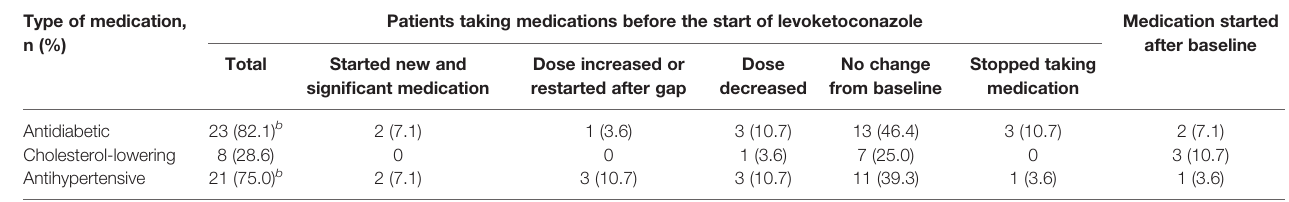
TABLE 4 | Changes from baseline in concomitant medication use (maintenance population; patients with DM, N = 28). a Type of medication, Patients taking medications before the start of levoketoconazole n (%) Started new and signi fi cant